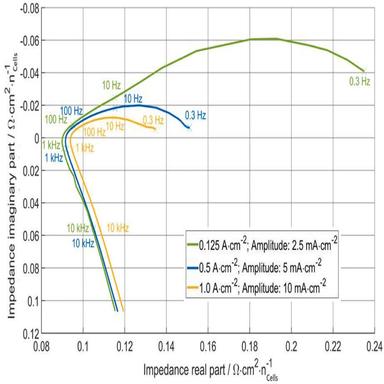
Nyquist plot for different stack impedance spectra.